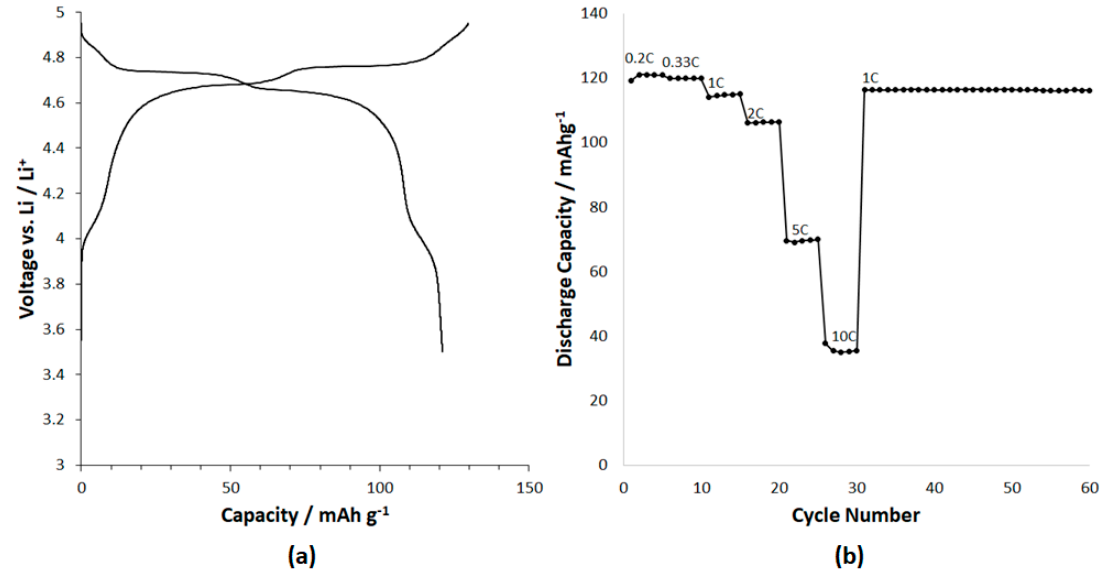
Figure 8. ( a ) Electrochemical charge and discharge curve of 30% Li 1.25 Cr 0.25 Mn 1.5 O 4 and 70% LiNi 0.5 Mn 1.5 O 4 solid solution formed at 850 °C (nominal composition: Li 1.025 Cr 0.025 Ni 0.45 Mn 1.5 O 4 ) ( b ) Discharge capacity of Li 1.075 Cr 0.075 Ni 0.35 Mn 1.5 O 4 as function of charge and discharge rate at a loading of about 6 mg cm − 1 (~ 0.7 mAh cm − 1 ). Symmetrical charge and discharge rate indicated on the figure were varied each five cycles (cycles 1–30) and fixed at 1C for cycles 31 ‐ 60.